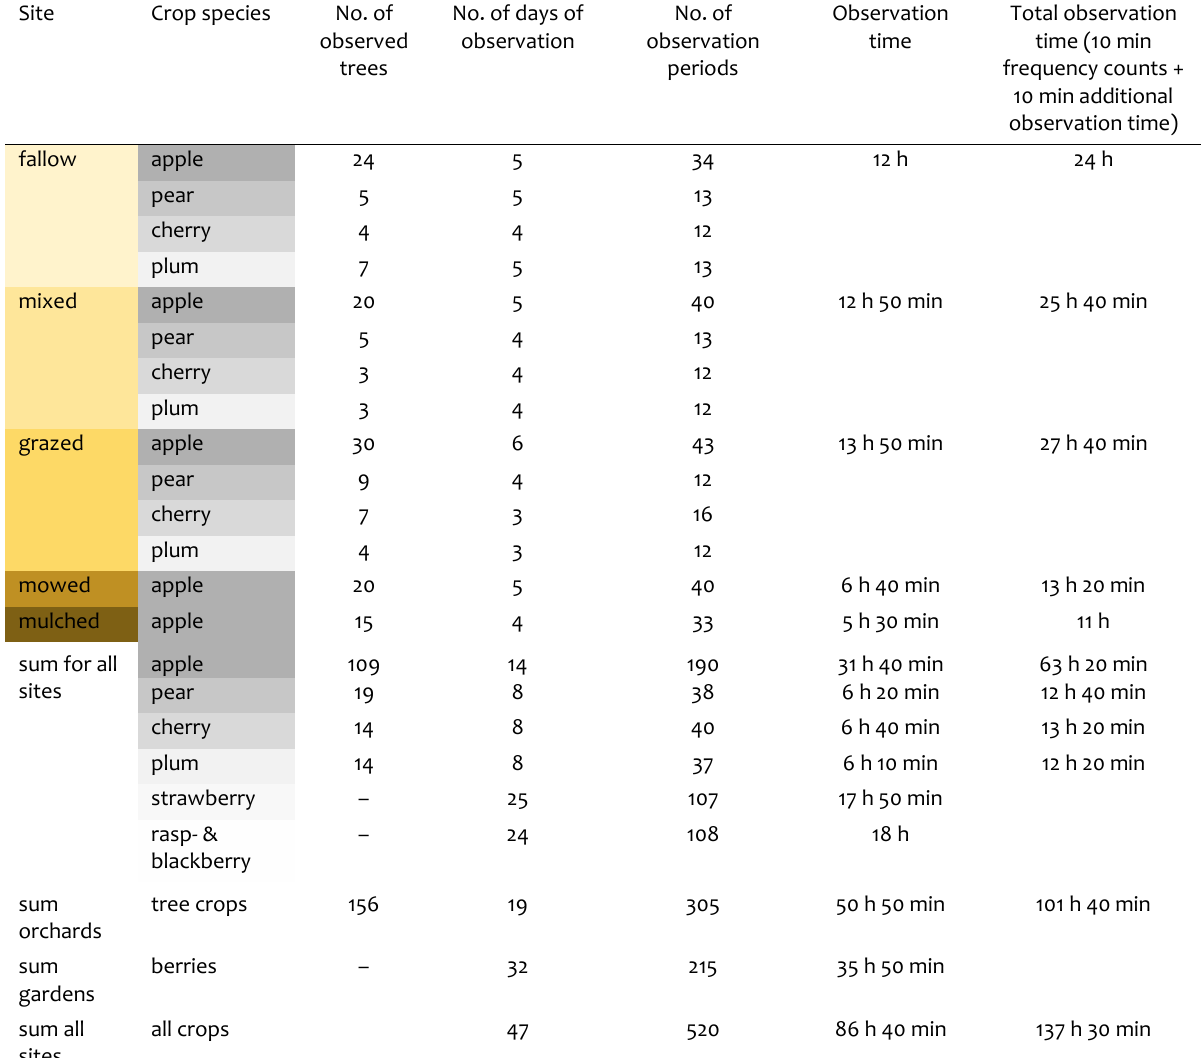
Table 2. Observation time per study site and crop